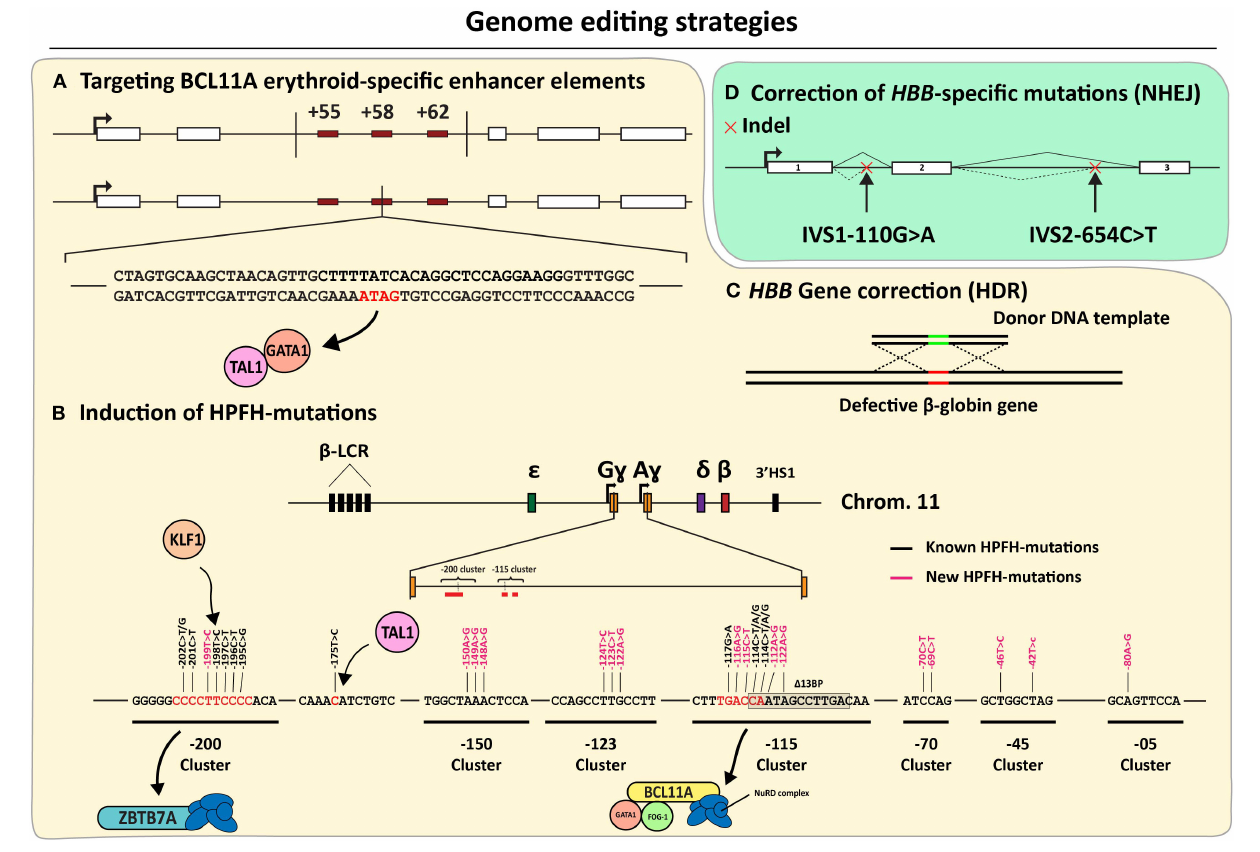
FIGURE 6 | An overview of the genome editing strategies directed at correcting β -hemoglobinopathies. (A–C) Mutation-independent gene editing strategies. (A) Disruption of erythroid-specific BCL11A expression through the disablement of enhancer elements based on, targeted deletions or GATA1-binding site disruption. (B) Introduction of HPFH or HPFH-like mutations near the HBG transcriptional start sites. (C) HDR-dependent HBB correction. (D) Mutation-specific NHEJ-dependent strategies targeting aberrant splice motifs for the correction of β